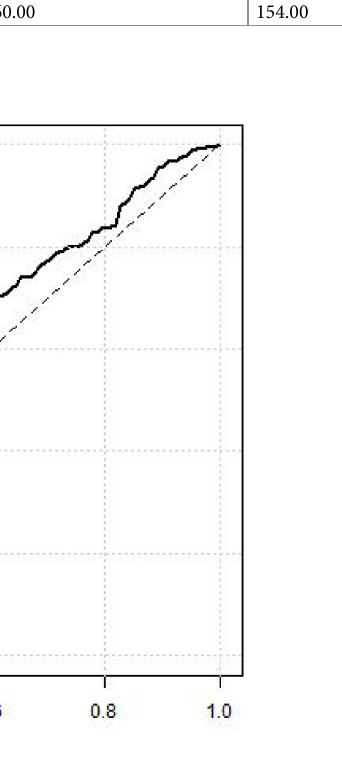
Fig 7. TTT plot of survival times of breast